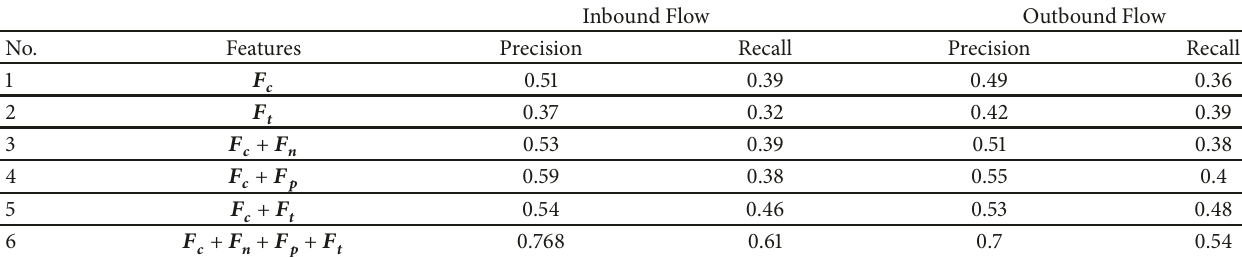
Table 1: RF prediction result